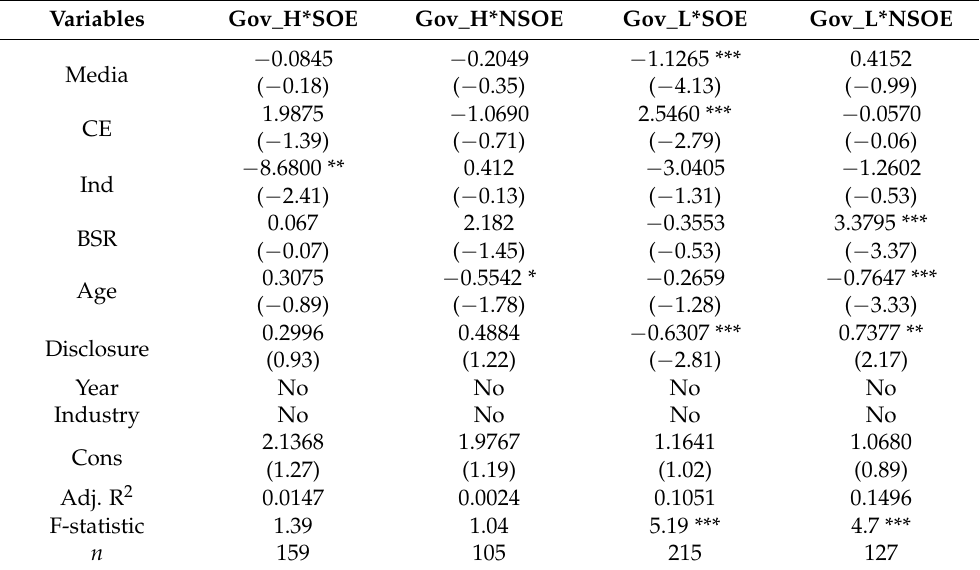
Table 7. Local governments’ emphasis on environmental protection and the breakdown of prop- erty